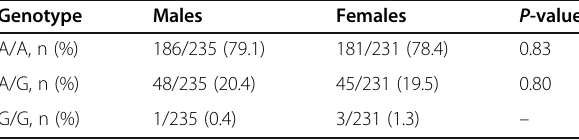
Table 2 Distribution of the three genotypes of rs2228262 in the study population Genotype